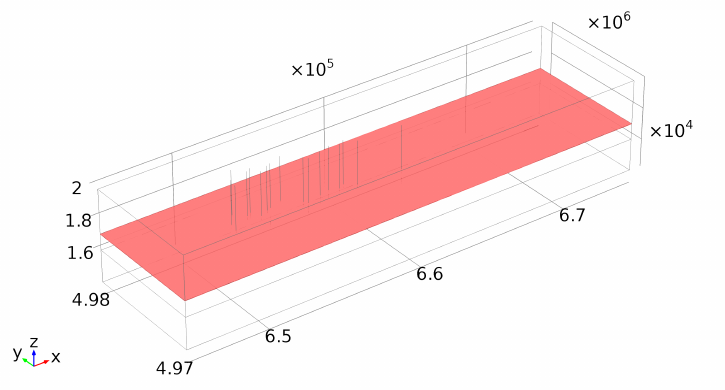
Figure 6. Cavone oilfield modeling: Top of reservoir layer where pressure is plotted in the three layers model, dimensions being in